Question: Author a descriptive caption for the visualization shown.
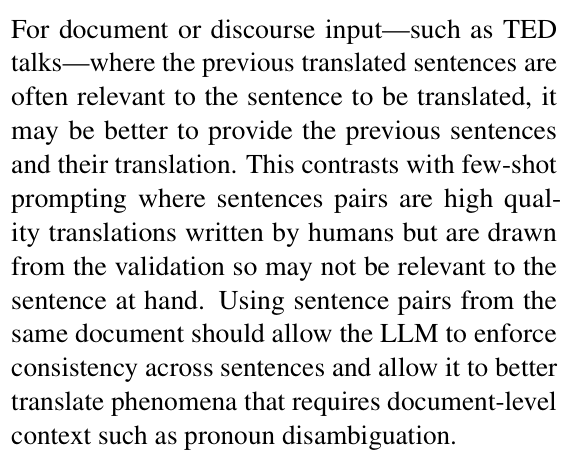
Answer: shows the COMET-22 score against the number of sentence pairs in the prompt on the TED-100 test set. Prompting the LLM with docu- ment context outperforms few-shot prompting and the ensemble with context (solid orange line) to outperform all variants of ensembling and LLMs with context or few-shots, as well as the MT model. Conditioning on the model’s own previous outputs from the same document context outperforms few- shot prompting with the human references of less related sentences. Prior work found that document level-specific evaluation is required to evaluate document level phenomena (Läubli et al., 2018; Toral et al., 2018; Vernikos et al., 2022). To this end, we use CTXPro (Wicks and Post, 2023), a specialized test suite